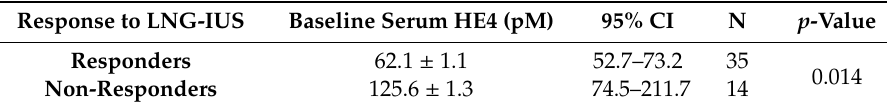
Table 3. Mean baseline serum HE4 in responders compared to non-responders to the levonorgestrel-releasing intrauterine system (LNG-IUS) in patients with atypical hyperplasia (AH) / Stage1a low grade endometrial cancer (EEC).